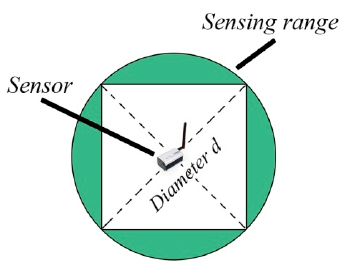
Figure 3. The sensing area of sensor in terms of square.